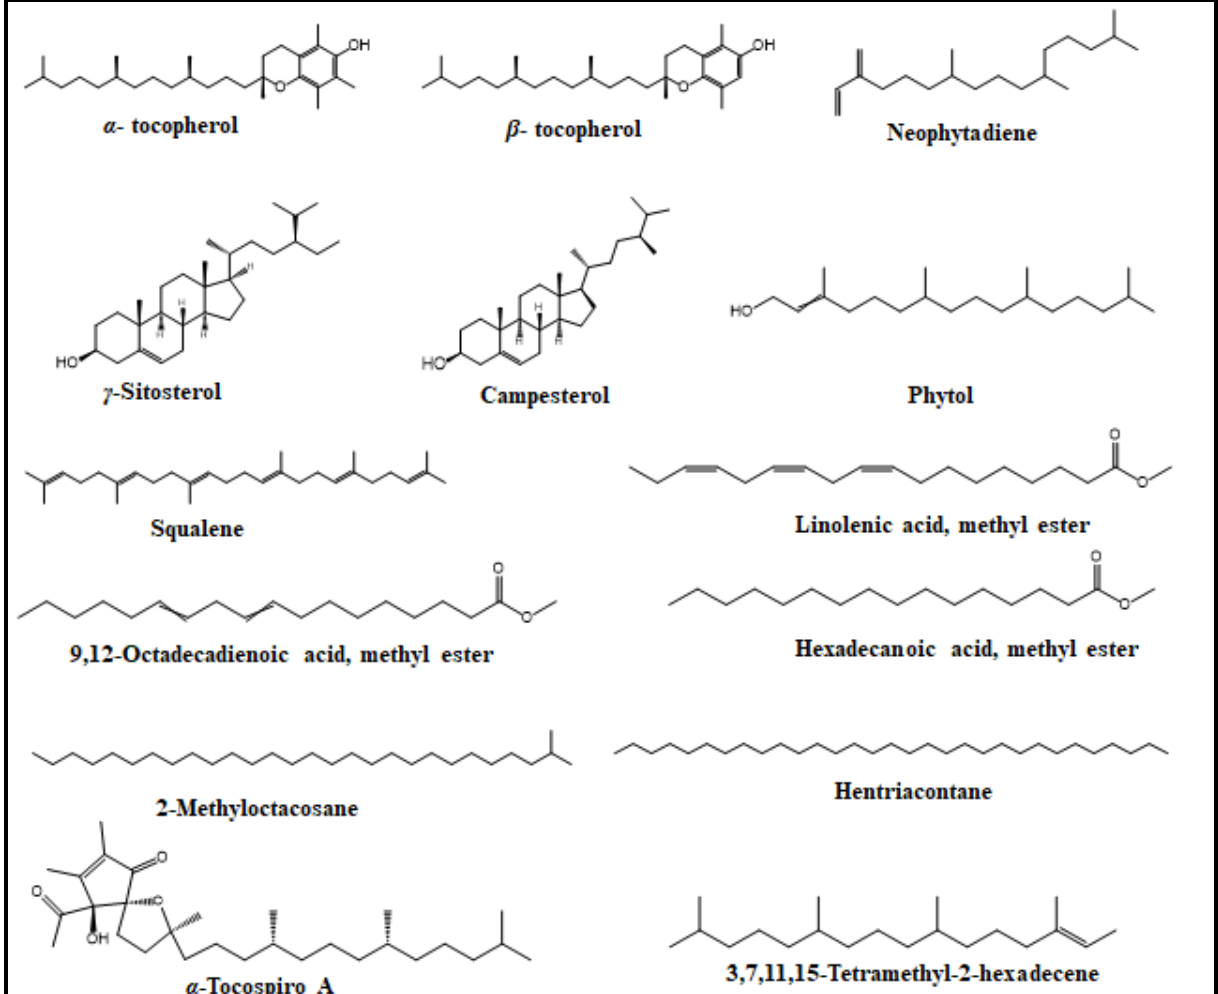
Figure 2. Major constituents of Stenocarpus sinuatus hexane-soluble fraction.